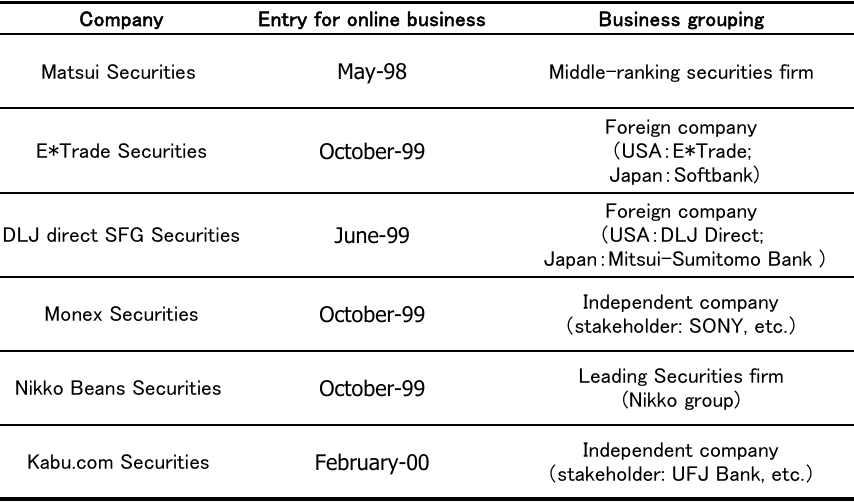
Table 1. Profile of Six Companies Covered in the Case